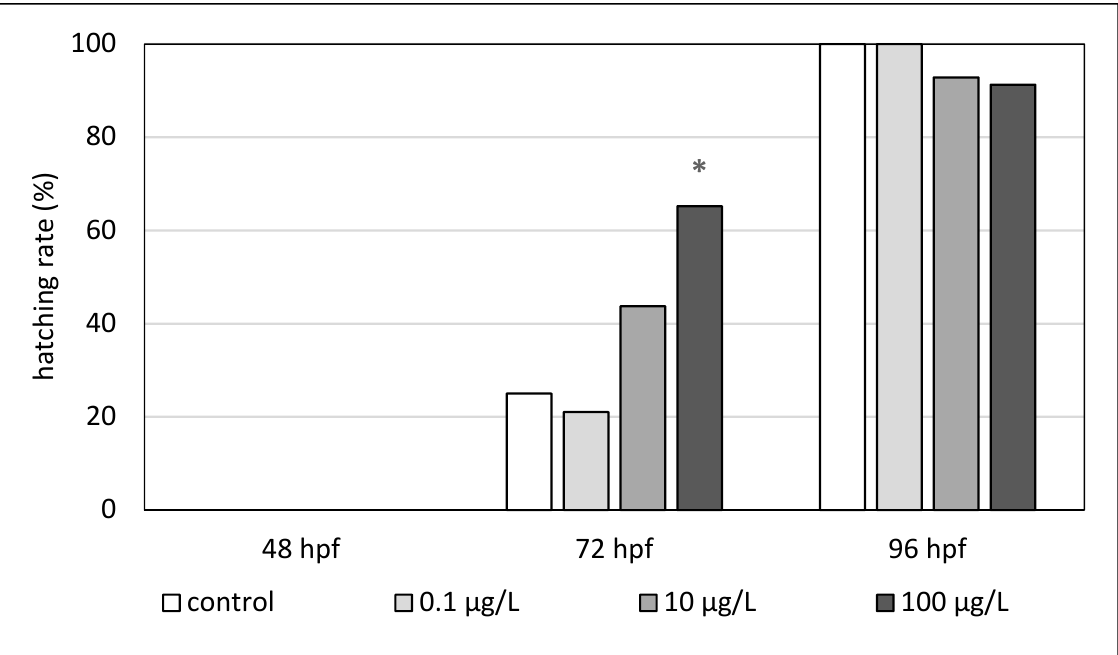
Figure 5. Hatching rate (%) of zebrafish embryos exposed to the combination of octocrylene and 4-methylbenzylidene